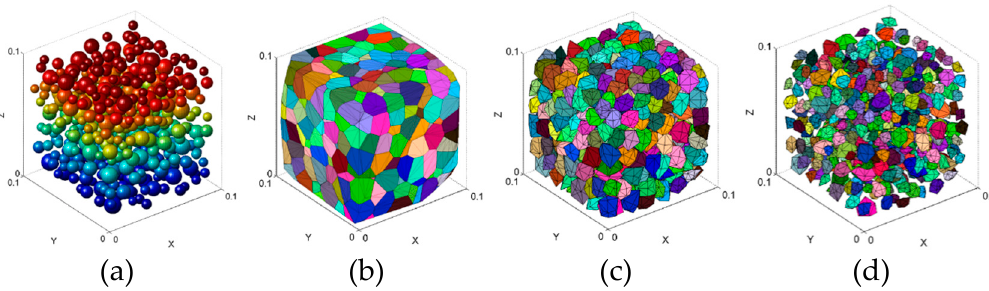
Figure 2. The generating process of the aggregates in concrete: ( a ) throw the spheres randomly in a specified region and extract the spheres centers as the seeds, ( b ) generate the Voronoi polyhedrons based on extracted seeds, ( c ) simplify the generated polyhedrons, ( d ) obtain the aggregates by zooming simplified polyhedrons.